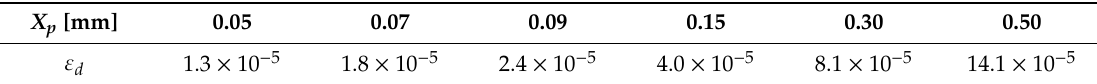
Table 1. Dynamic amplitude at the piston X p and corresponding dynamic strain ε d .